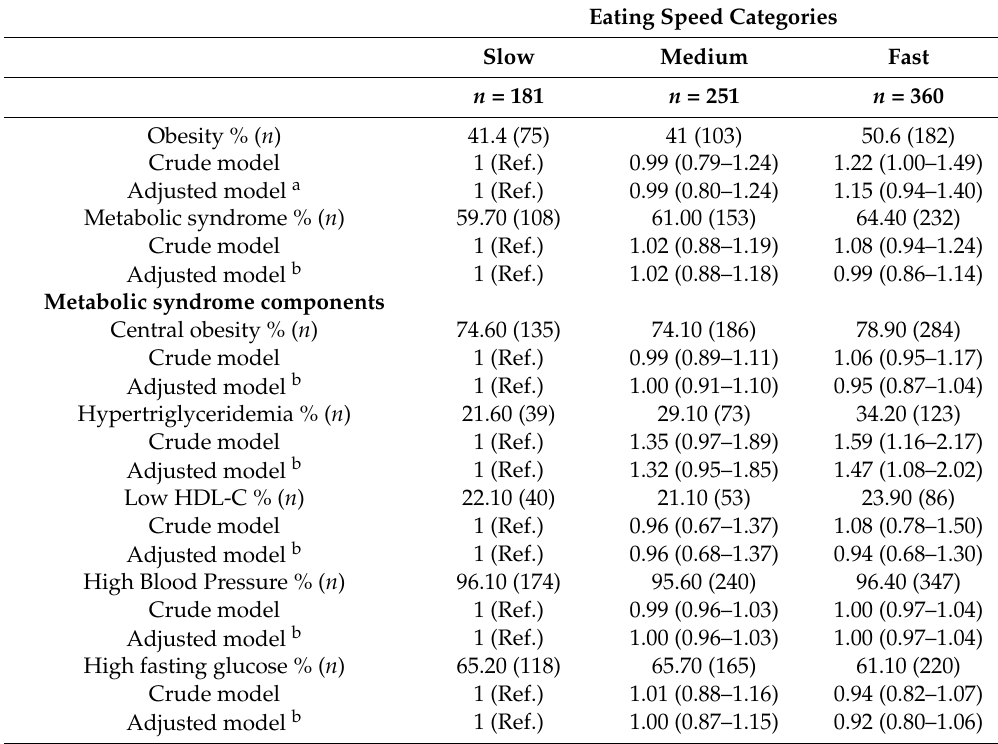
Table 3. Hazard ratio (95% CI) of different cardiovascular risk factors for self-reported eating speed